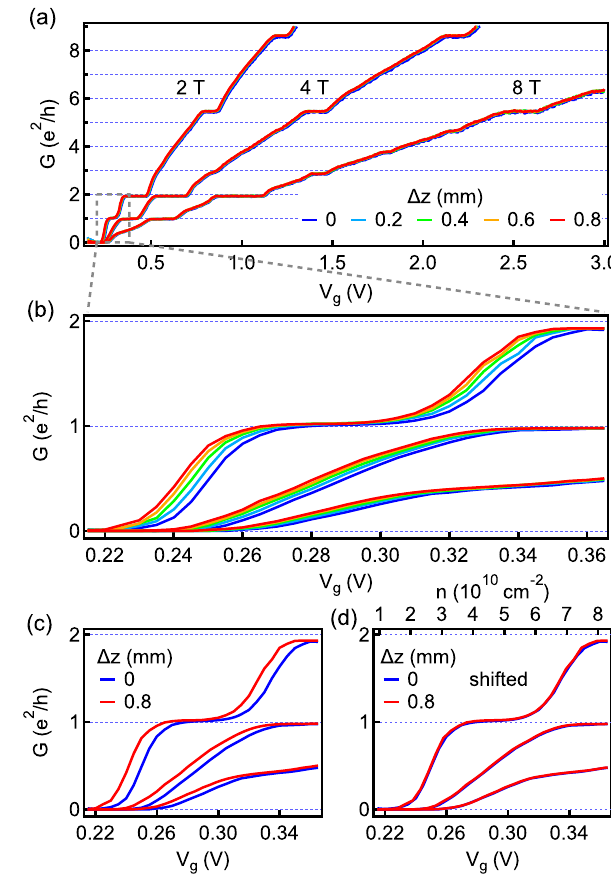
Fig. 3 Measurements in the quantum Hall regime. a Two-terminal differential conductance as a function of gate voltage V g at three different magnetic fi elds for different displacement Δ z . b Zoom-in to a small region in ( a ), showing the shift of the curves in V g with increasing Δ z . c Same as in ( b ) for Δ z = 0 and Δ z = 0.8 mm. d Same as in ( c ) with the Δ z = 0.8 mm curve (red) shifted to the right by 8 mV in V g . The corresponding carrier density is shown on the top